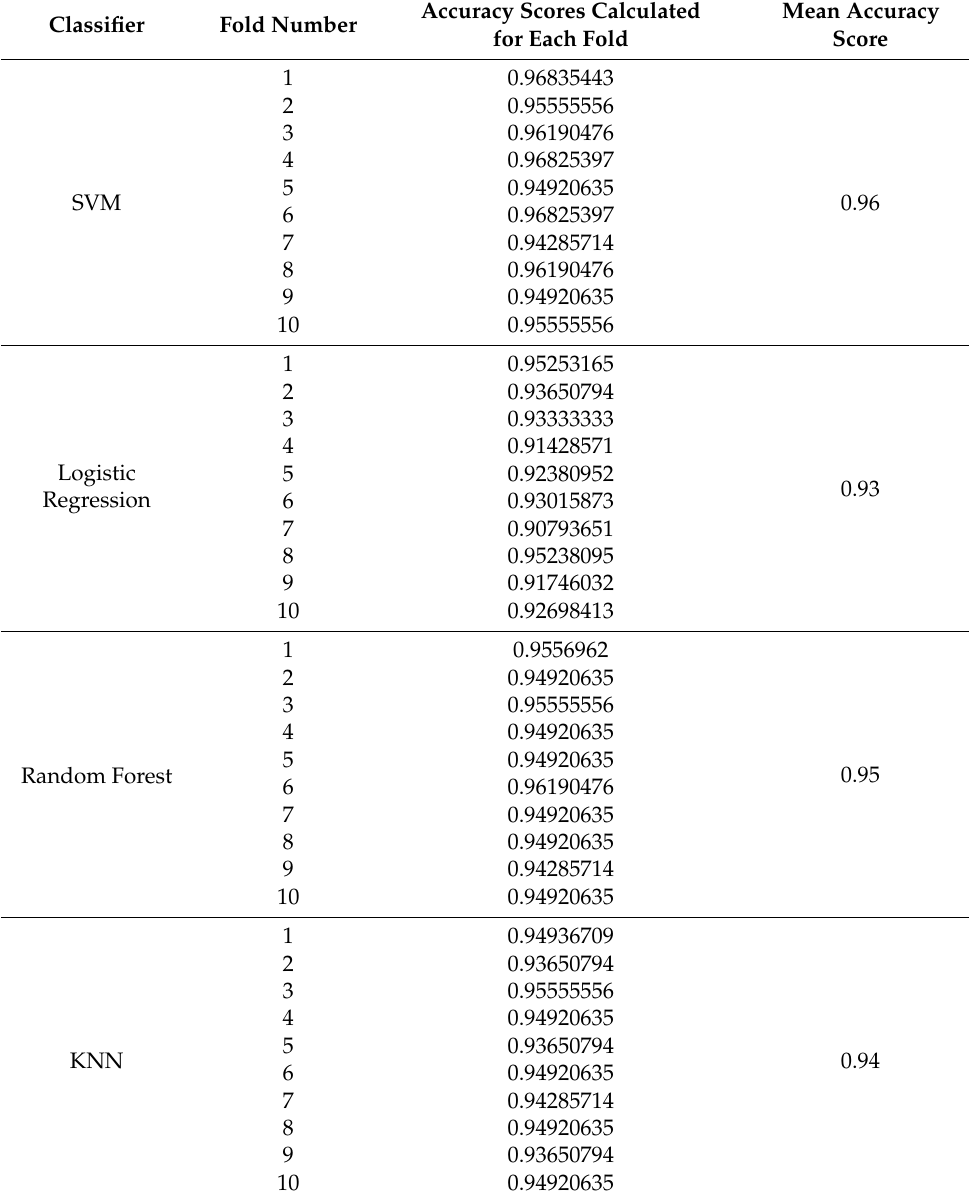
Table 9. 10-Fold cross-validation results for each classifier.